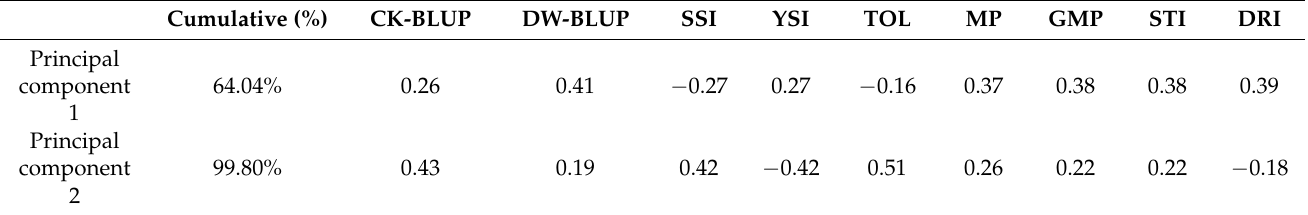
Table 5. Principal component analysis of best linear unbiased predictors for yield and the drought tolerance